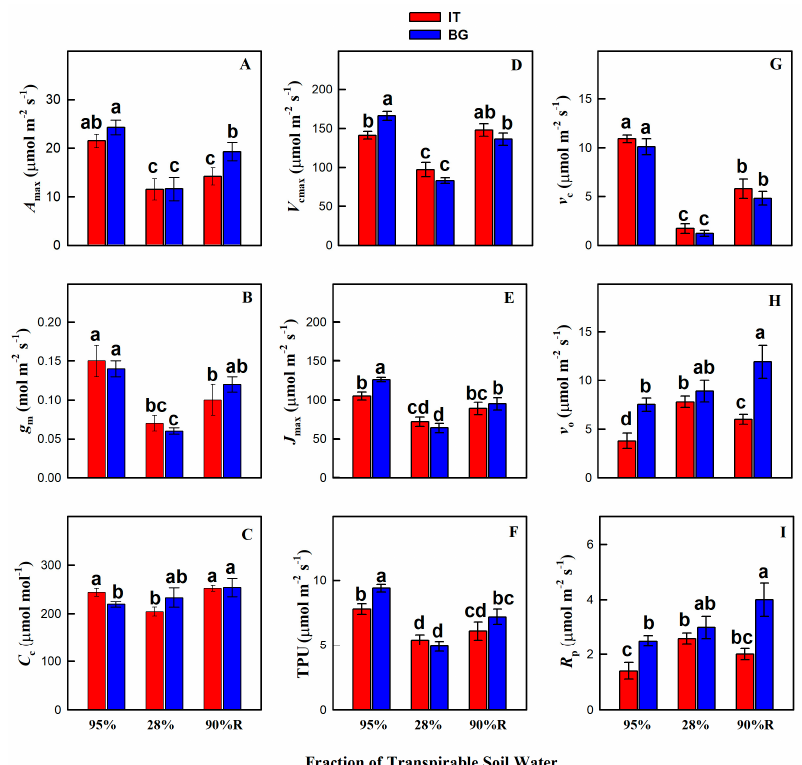
Figure 2. Photosynthetic parameters in Italian (IT, red bars) and Bulgarian (BG, blue bars) populations of P. orientalis plants under control (FTSW = 95%) and drought (FTSW = 28%) conditions and after re-watering (FTSW = 90%R). CO 2 saturated photosynthetic rate ( A sat , panel A ), mesophyll conductance ( g m , panel B ), chloroplastic [CO 2 ] at C i = 400 ppm ( C c , panel C ), maximum carboxylation rate of Rubisco ( V cmax , panel D), maximum rate of photosynthetic electron transport ( J max , panel E ), triose phosphate utilization (TPU, panel F ), carboxylation rate ( v c , panel G ), oxygenation rate ( v o , panel H ) and photorespiration rate ( R p , panel I ). Data are means ± SE of eight independent samples. Statistically significant differences (Tukey’s test, p < 0.05) between the IT and BG ecotypes are indicated by different letters.